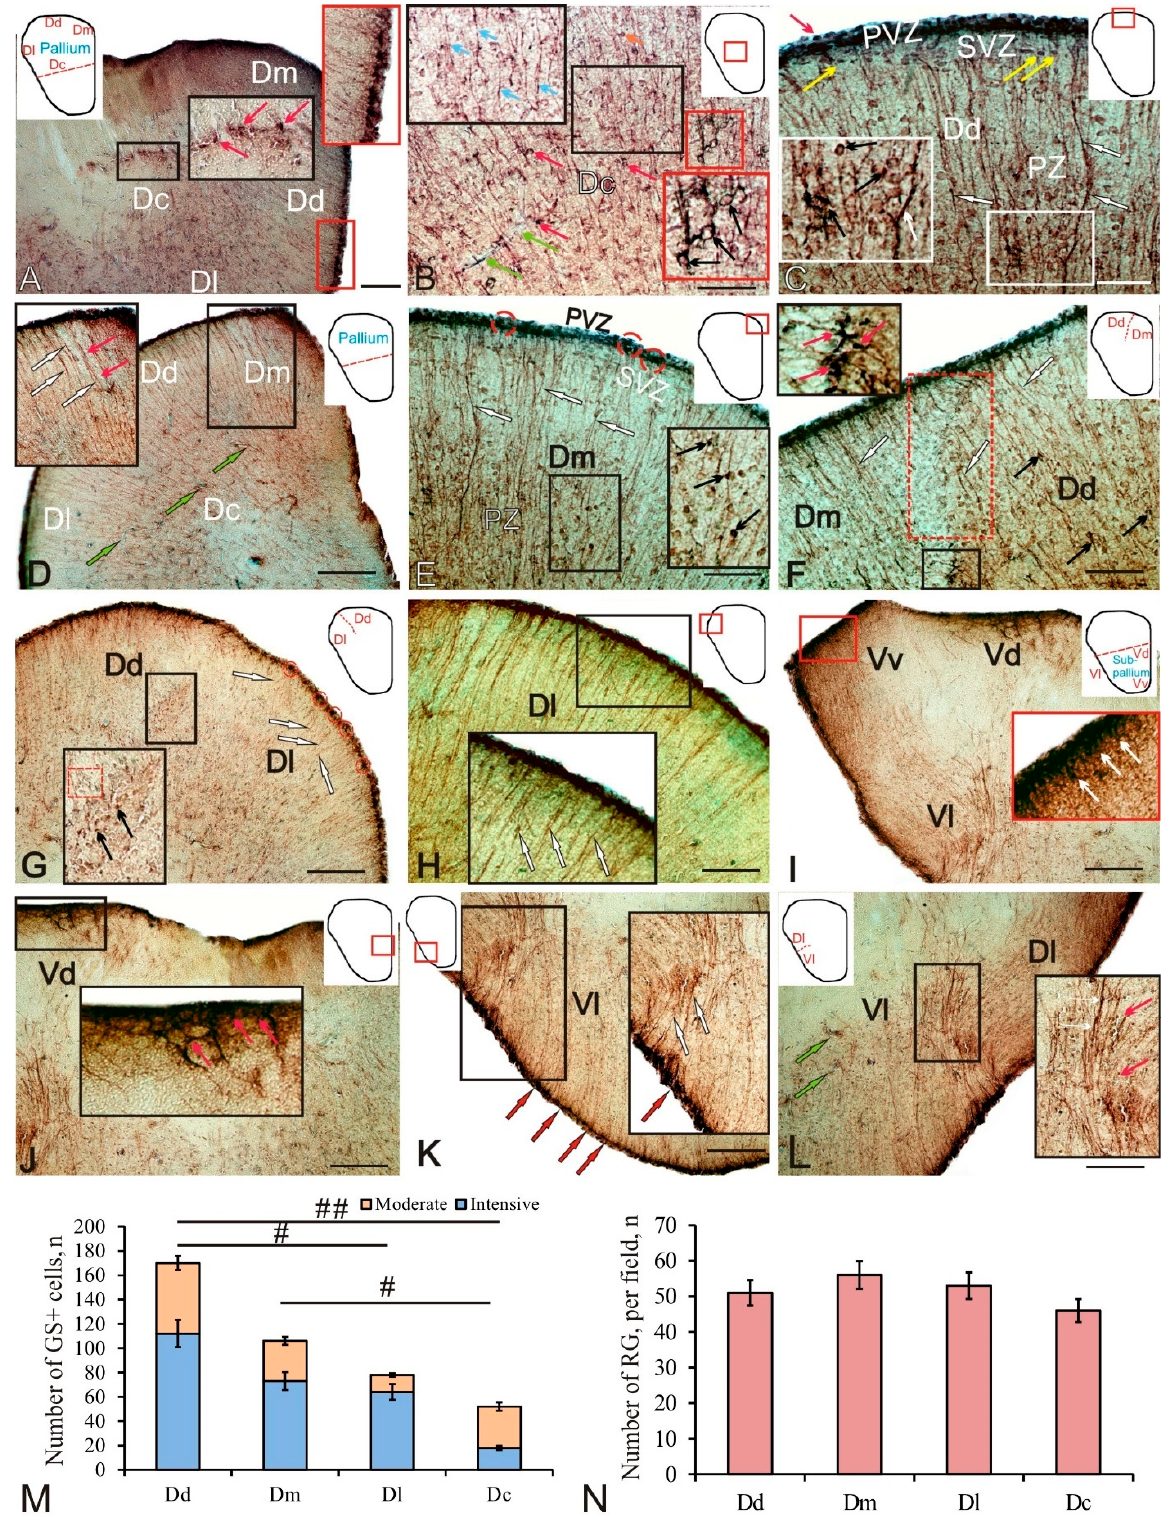
Figure 1. Glutamine synthetase (GS) in the pallial and subpallial regions of the telencephalon in trout, Oncorhynchus mykiss : ( A ) A general view of GS immunolocalization patterns in the trout pallium (Dd—dorsal, Dm—medial, Dl—lateral, and Dc—central zones of pallium); the pictogram shows the zones of the dorsal telencephalon (pallium), the dotted line separates the pallium from the subpallium, aggregations of GS+ cells, intensely labeled cells (red arrows) in Dc (inset in black rectangle), and periventricular area zone (Dd, inset in red rectangle). ( B ) Central pallial zone (Dc) at a higher magnification; inset (in black rectangle) shows a fragment including radial glia (light blue